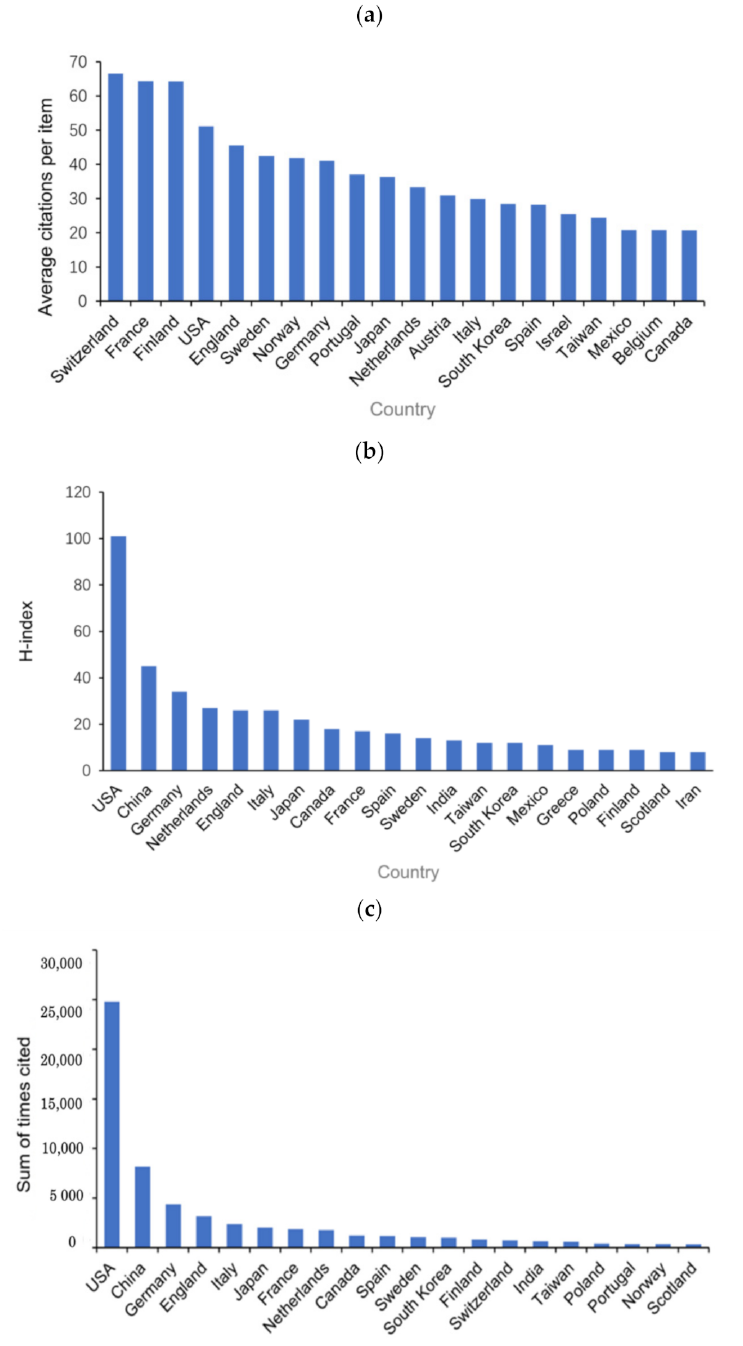
Figure 2. Citation frequency and H-index levels of different countries. ( a ) Total citations of the AS research articles from different countries. ( b ) Average citations per paper for articles from different countries. ( c ) The H-index of publications in the different